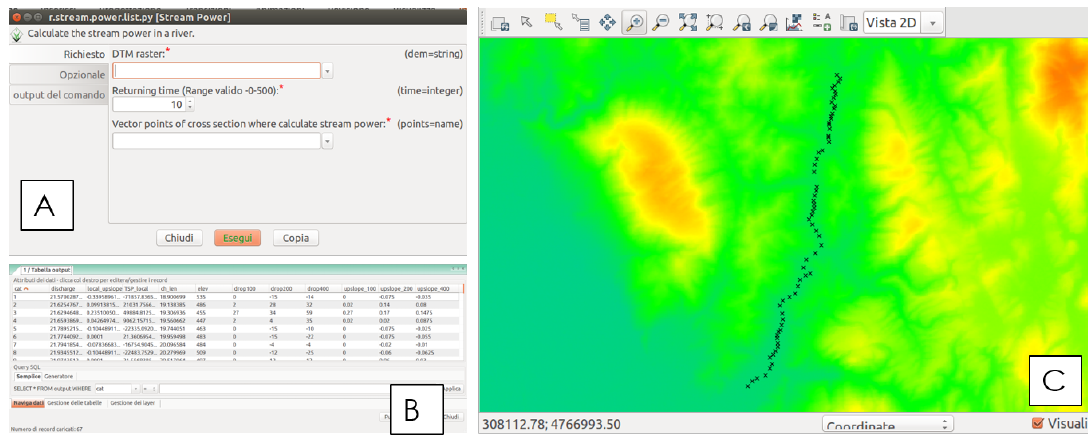
Figure 5. ( A ) The user interface of the r.stream.power , the module of GRASS GIS. Required inputs are vector points that represent the locations of cross-sections at which the stream power and DEM should be calculated. ( B ) The model output represented by a vector points layer; the attribute table contains, in detail, all of the code-calculated parameters, such as discharge, downstream channel length from the source point, local elevation, elevation drops, upslope for several distances, and the TSP for upslope distances of 100, 200, and 400 m. ( C ) Output points generated by the code plotted over the DEM used as